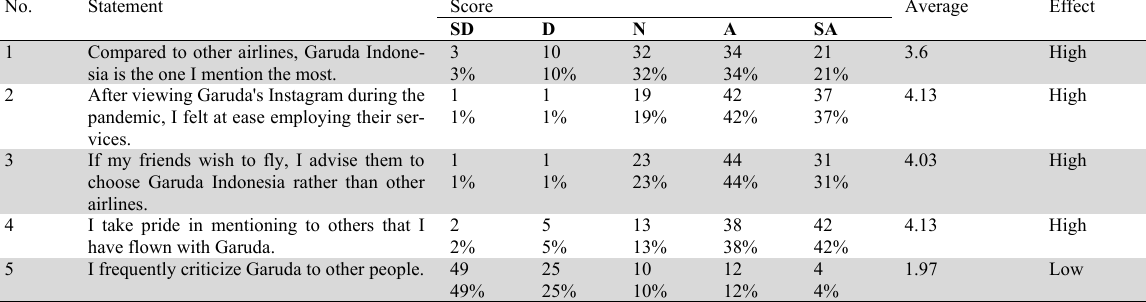
The distribution of responses to indicators for electronic word-of-mouth variables No.